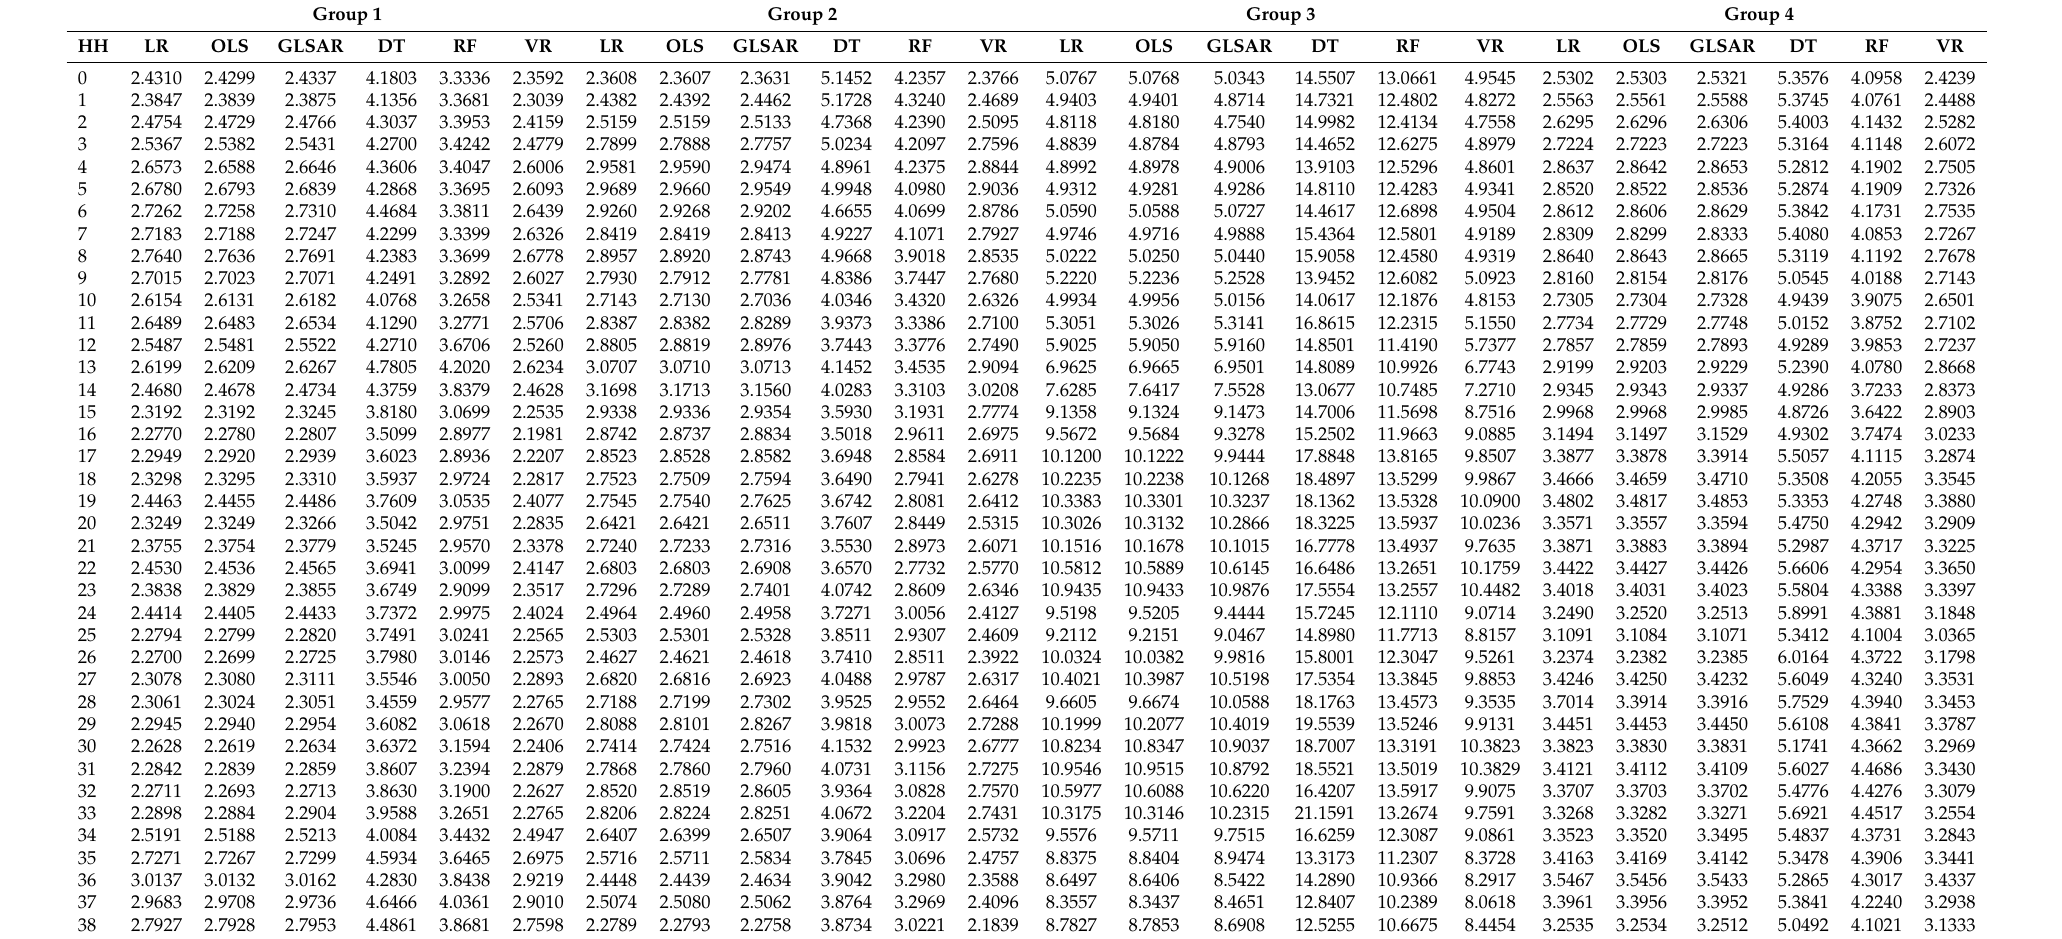
Table A6. Blocked-CV MAPE value (in %) obtained by each half-hourly model in each